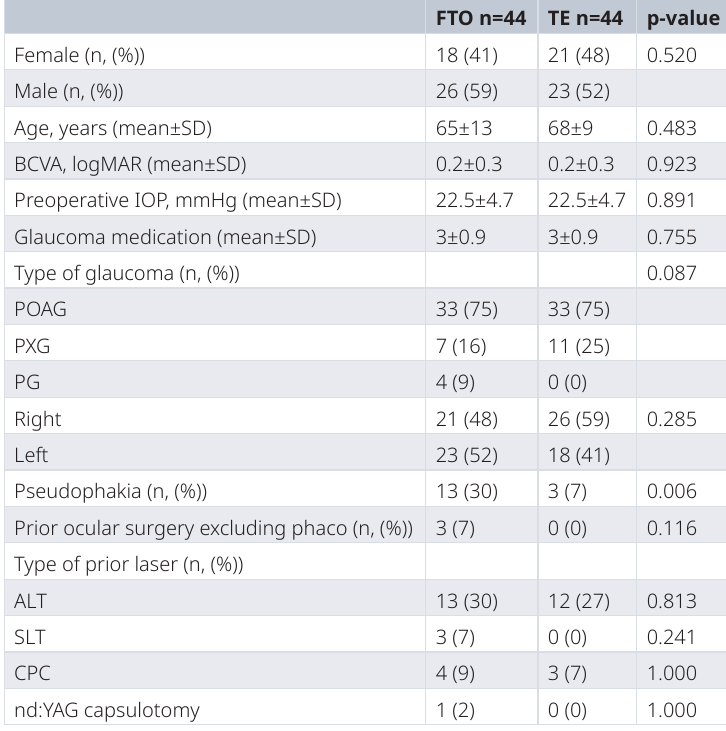
(Table 1). There were no significant differences between FTO and TE in gender, age, best-corrected visual acuity, type of glau- coma, or surgical side. In FTO, 13 eyes were pseudophakic